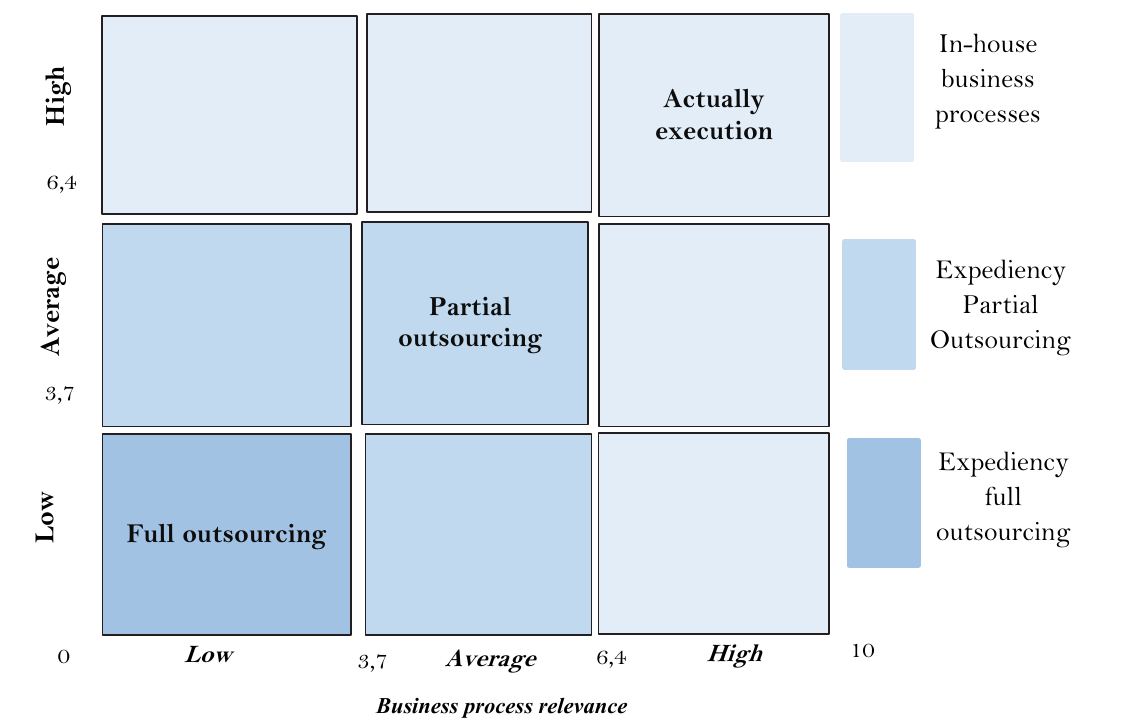
Fig. 3. The matrix of the feasibility of implementing outsourcing in the